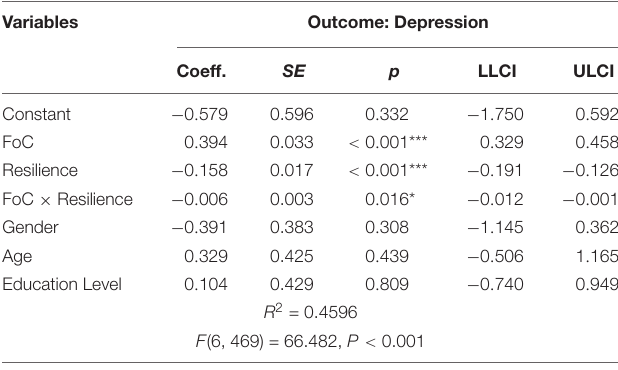
TABLE 5 | Results from a regression analysis examining the moderation of the effect of FoC on depression by resilience ( N = 476).